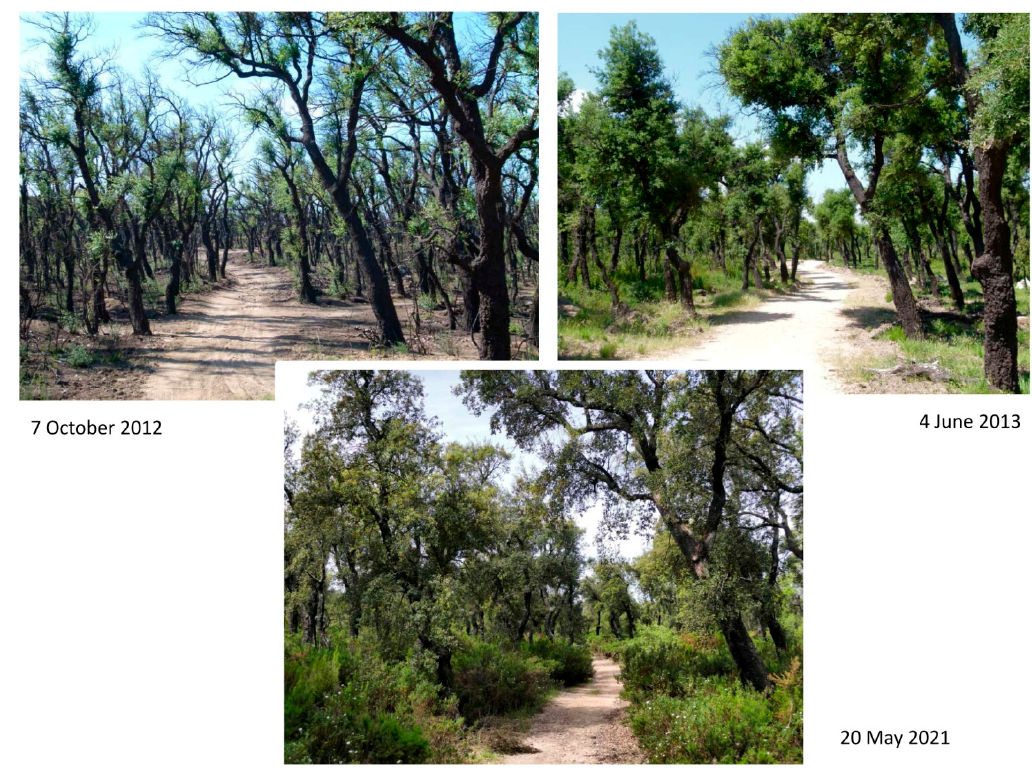
Figure A2. A view of transect “C”, the first autumn after the third fire (22 July 2012), the first spring after this fire, and the 9th spring after this fire, respectively.